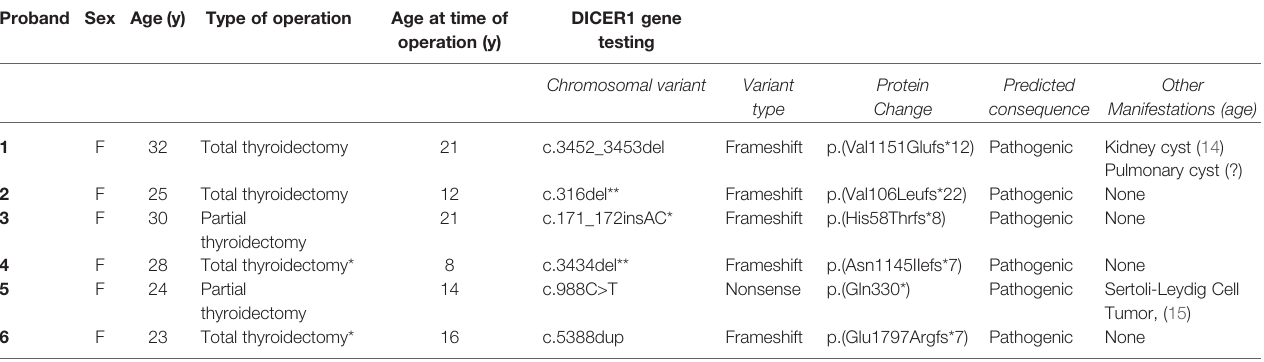
TABLE 2 | Characteristics of DICER1 probands identi fi ed in the goitre cohort. Proband Sex Age (y) Type of operation